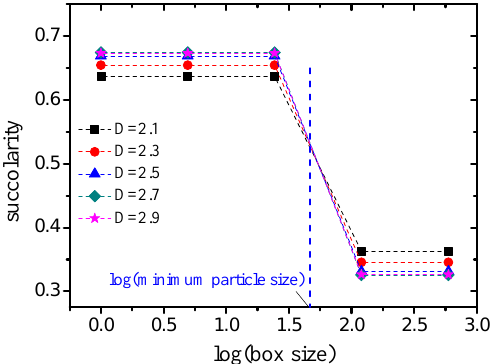
Figure 16. Variation in succolarity with box size (taking D = 2.5 as an